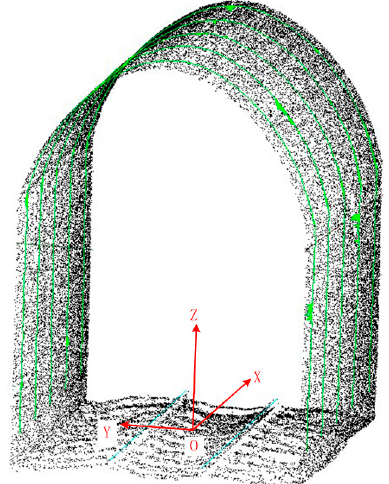
Figure 10. Tunnel clearance coordinate system.